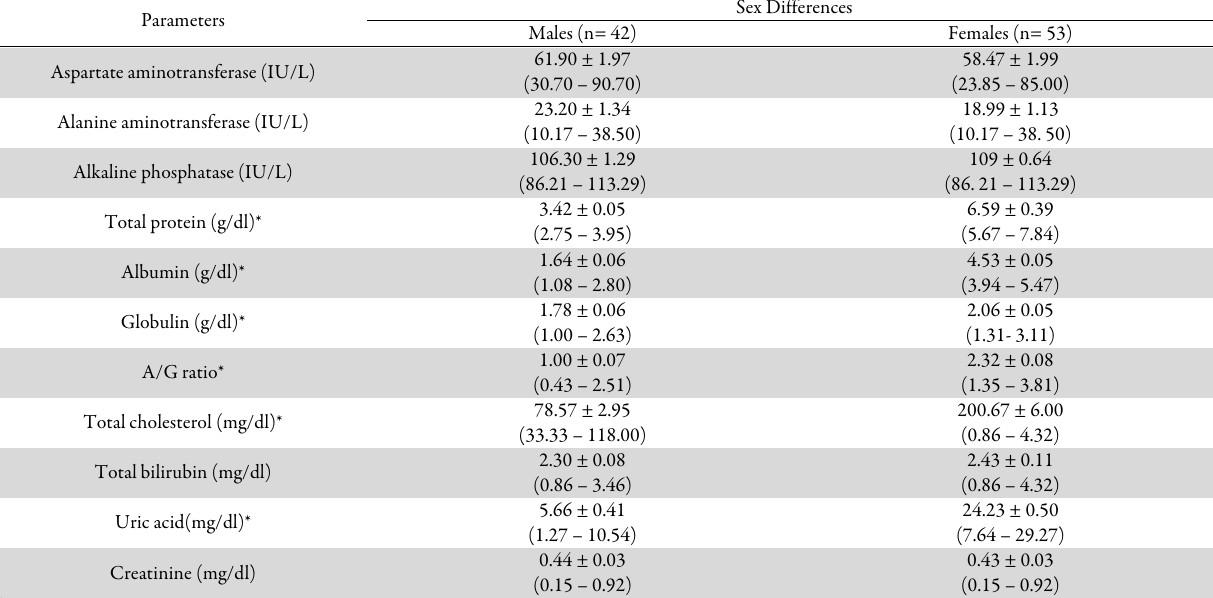
Table 4. Comparison of serum biochemistry profile of male and female adult Japanese quail (Courtinix courtinix japonica )